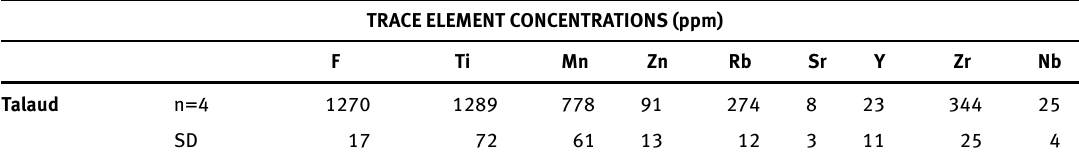
Table 5. Statistical summary of PIXE-PIGME data of Talaud (taken from Bird,